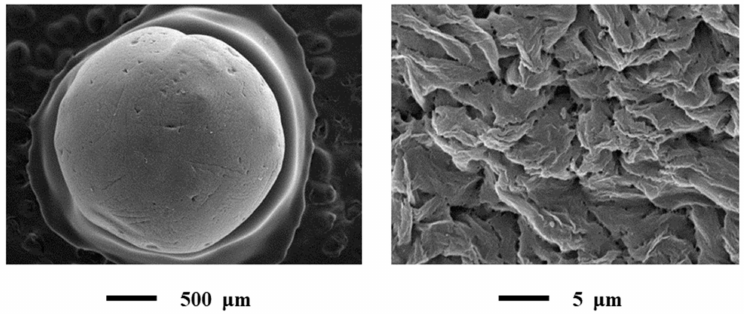
Figure 6. SEM of alginate-based aerogel particles: Single particle (on the left) and outer surface of the particle (on the